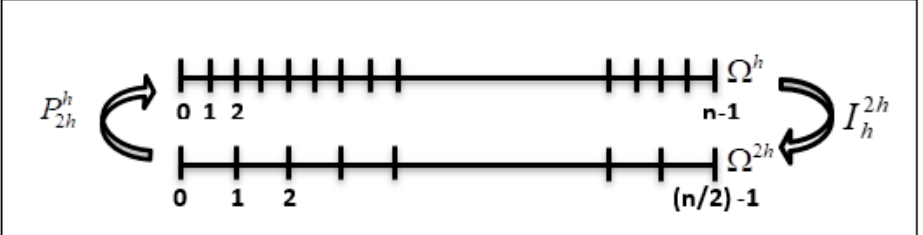
Figure 1. The fine grid and the coarse grid .